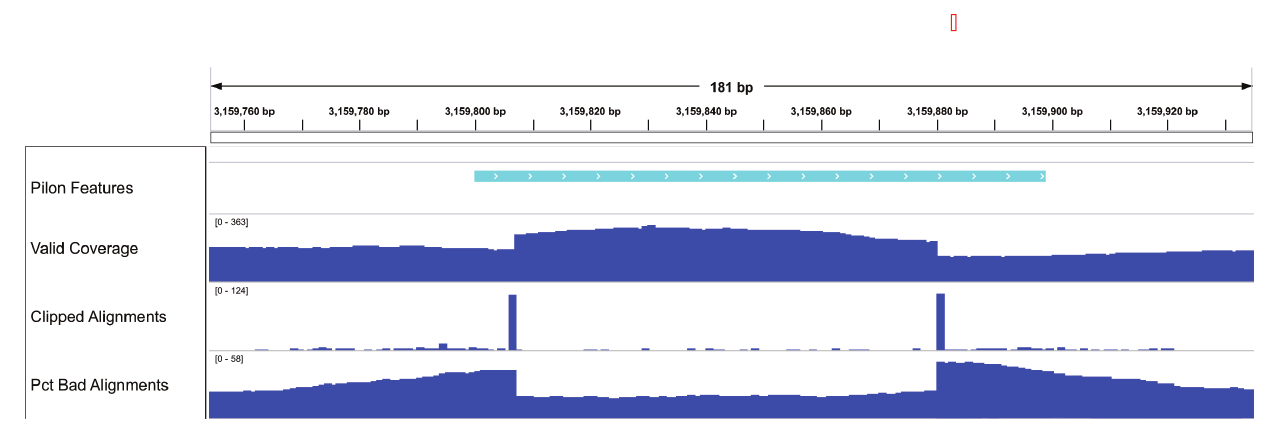
Figure 2. Example Pilon generated genome browser tracks. This region was flagged by Pilon as containing a possible local mis-assembly, but Pilon was unable to determine a fix due to a tandem repeat sequence. The tracks shown here include: Pilon Features track indicating the extent of the region flagged by Pilon as containing a potential mis-assembly, Valid Coverage track indicating the sequence coverage of valid read pair alignments excluding the clipped portions of the alignments, Clipped Alignments track indicating the number of reads soft-clipped at each location, Pct Bad Alignments track indicating the percentage of the total reads aligned to each location which are not part of Valid Coverage . These tracks are created with the ‘—tracks’ command-line option. Together, these tracks reveal the true bounds of the mis-assembly, and indicate that there are likely missing copies of the tandem repeat in the draft assembly. In this case, manual analysis revealed the draft assembly was missing two of three full copies of a 57-base tandem repeat.